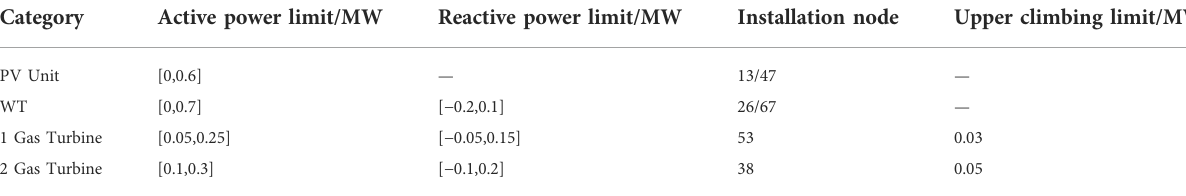
TABLE 1 Parameters of DGs.